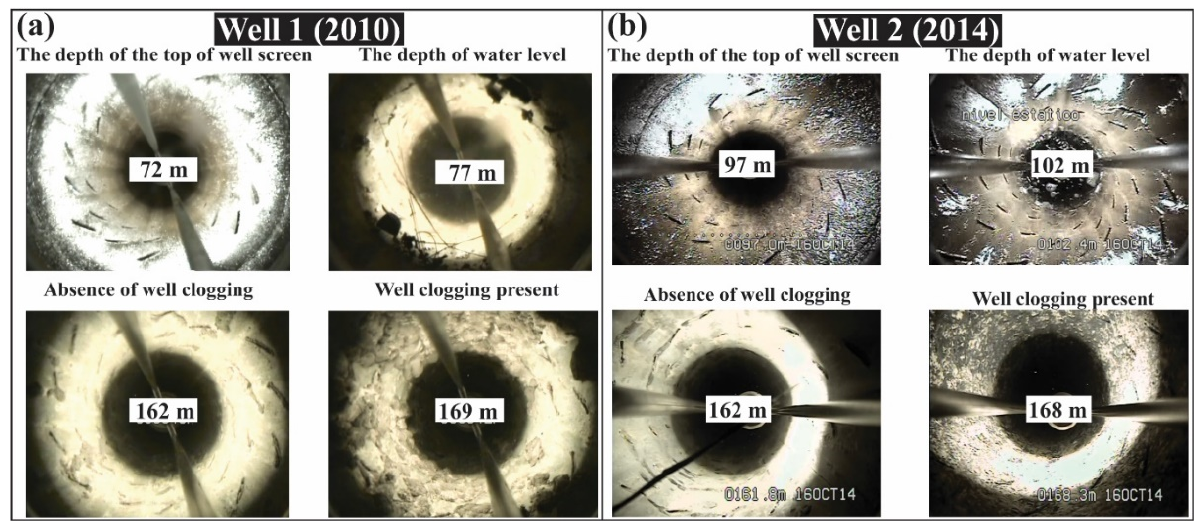
Figure 2. Snapshots of well log videos recorded with downhole camera in Wells 1 ( a ) and 2 ( b ), respectively. The parentheses next to the well ID indicate the year that the well log video was rec ‐ orded. Table 1. Well construction, static water level and pumping rates for the 7 municipal production wells of SMA.